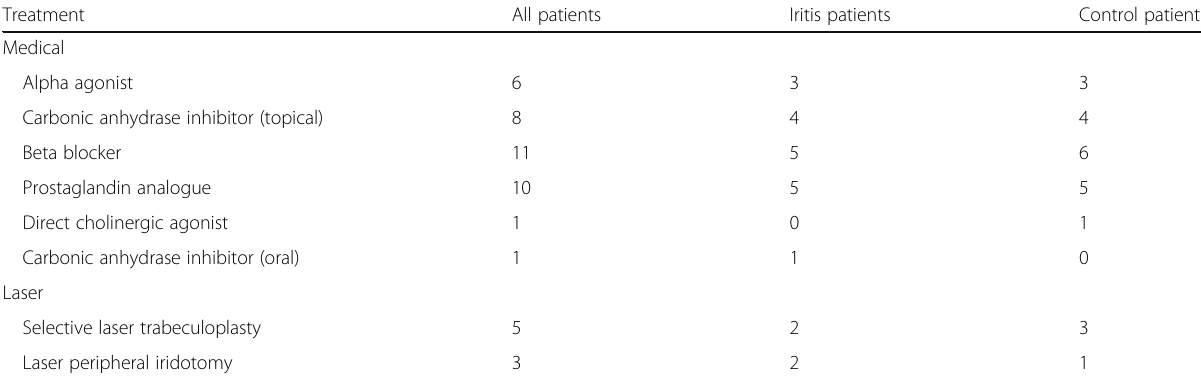
Table 3 Treatment comparison of glaucoma or glaucoma suspect patients Treatment All patients